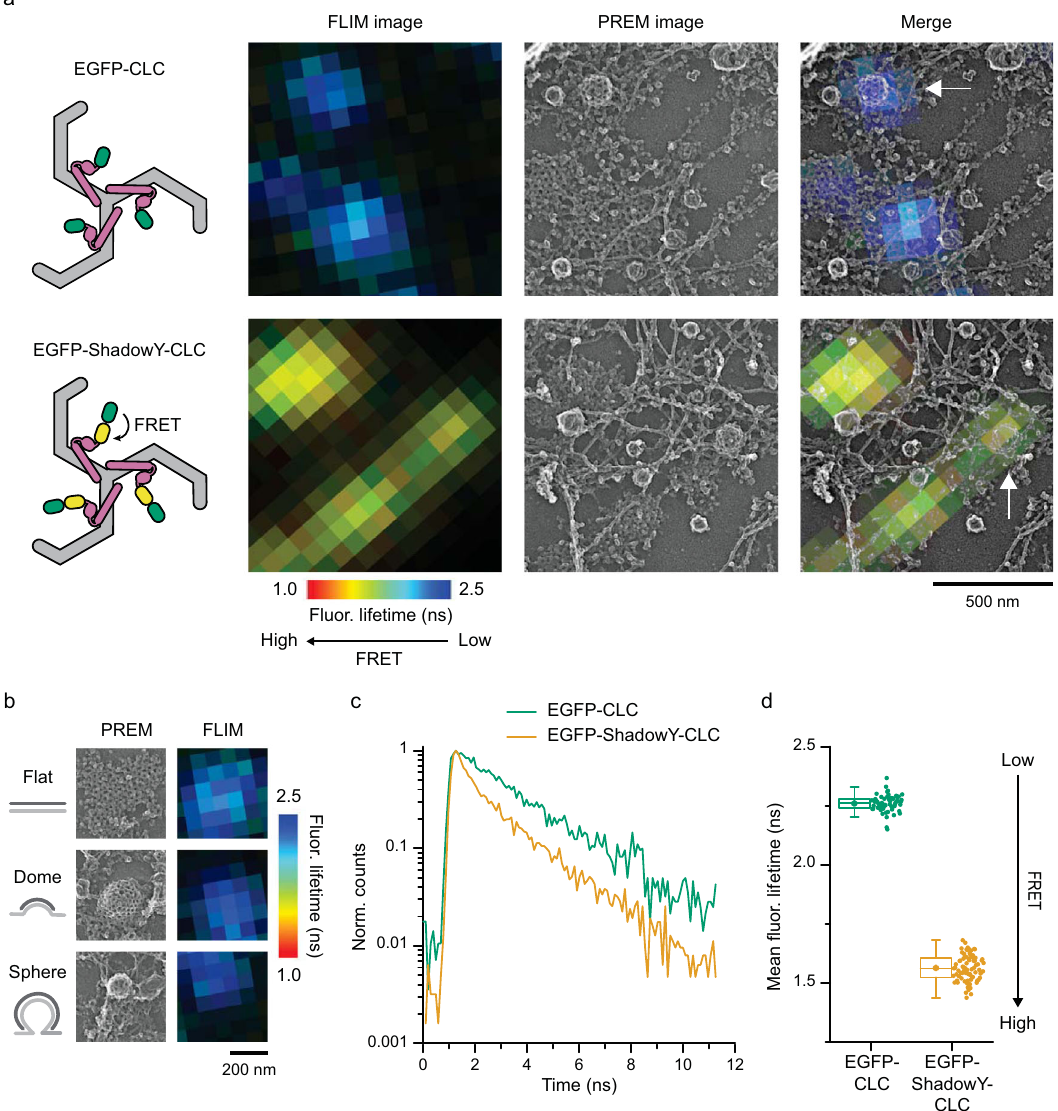
Fig. 1 | FRET-CLEM. a Correlative FLIM-FRET and PREM images of unroofed membranes of HeLa cells expressing EGFP-CLC (top) or EGFP-ShadowY-CLC (bot- tom). FLIM images (left; photon counts are represented by brightness and fl uor- escence lifetimes are represented by pseudo color), PREM images (center), and mergeimages(right). n =1cellforeachcondition.Scale500nm. b PREMimagesof CCSs on an unroofed membrane of a HeLa cell expressing EGFP-CLC that were classi fi ed as fl at, domed, or sphere and corresponding areas from a FLIM image.